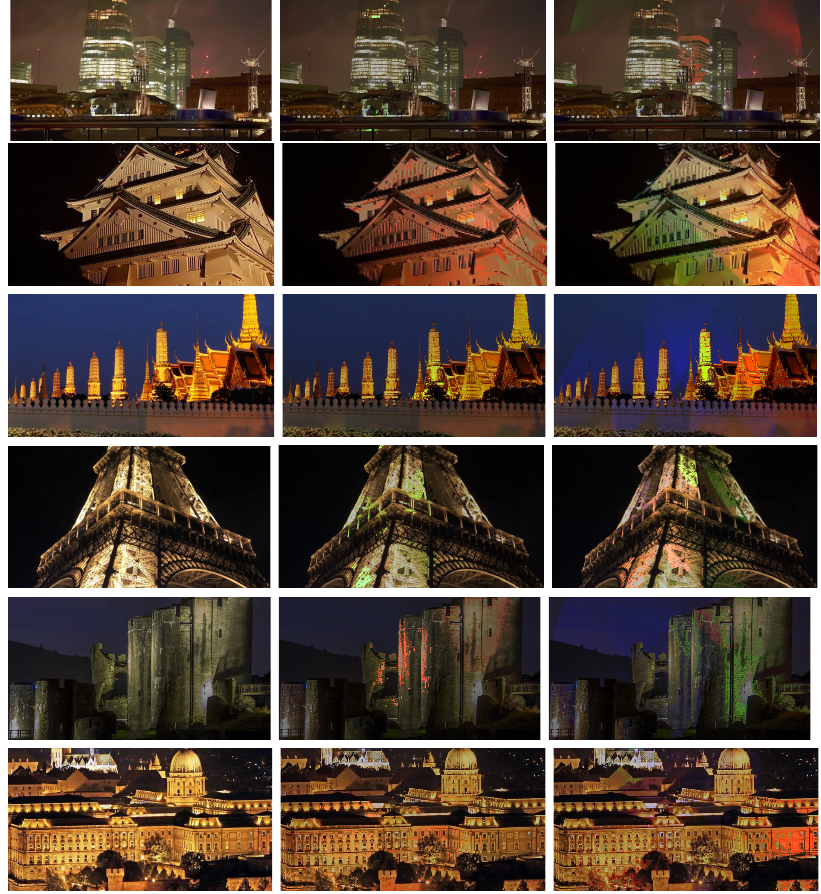
Figure 17. Expansion of output ( left : test images, center: Rendering results with omnidirectional diffusion, right : rendering results with directional diffusion